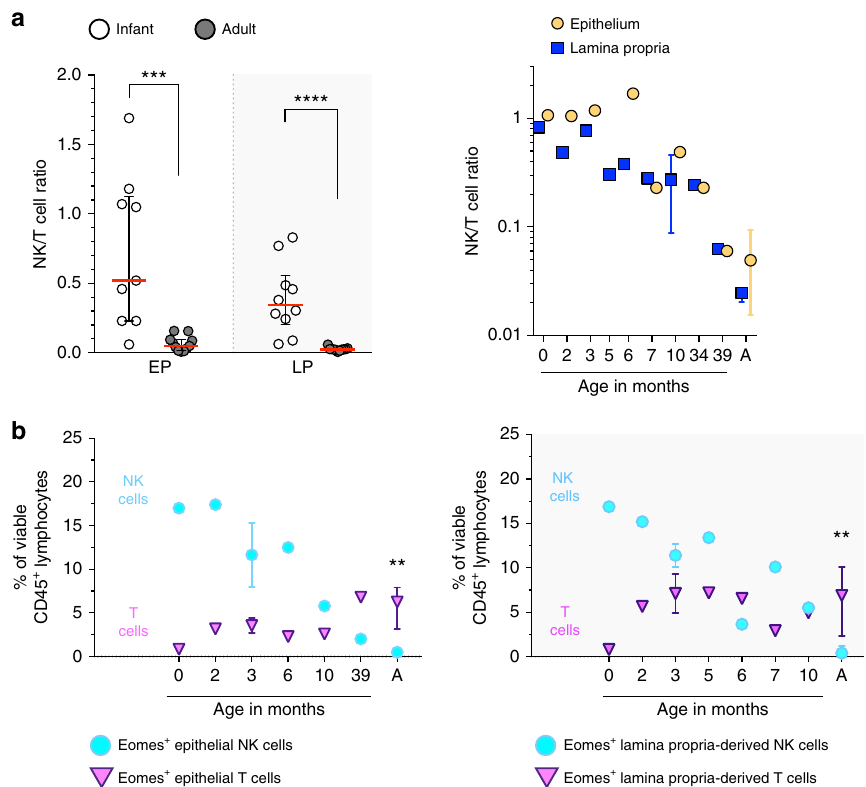
Fig. 8 Increase of intestinal Eomes + T cells in the fi rst year of life. a NK-T cell ratios of infant (white circles) and adult intestines (dark circles, A) in epithelium (EP, yellow circles) and lamina propria (LP, blue squares) (infant EP samples ( N = 9) and LP samples ( N = 10), adult EP and LP samples ( N = 11). b Frequencies of epithelium and lamina propria-derived Eomes + NK (turquoise circles) and Eomes + T cells (violet triangles) within the total lymphocyte pool at different ages (infant EP and LP samples ( N = 7) and adult EP and LP samples ( N = 10)). Median frequencies indicated by red lines. Error bars de fi ne interquartile ranges between 75th and 25th percentiles. Statistical comparisons are Mann-Whitney U comparisons. Asterisks represent the following p -values: ** p < 0.01; *** p < 0.001; and **** p <